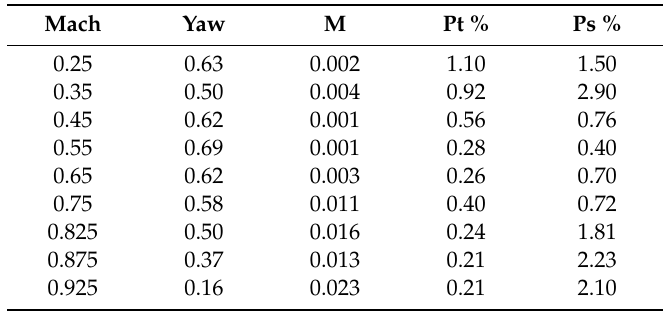
Table 1. Averaged errors ( δ ) for the Yaw, Mach, total and static pressure. Mach